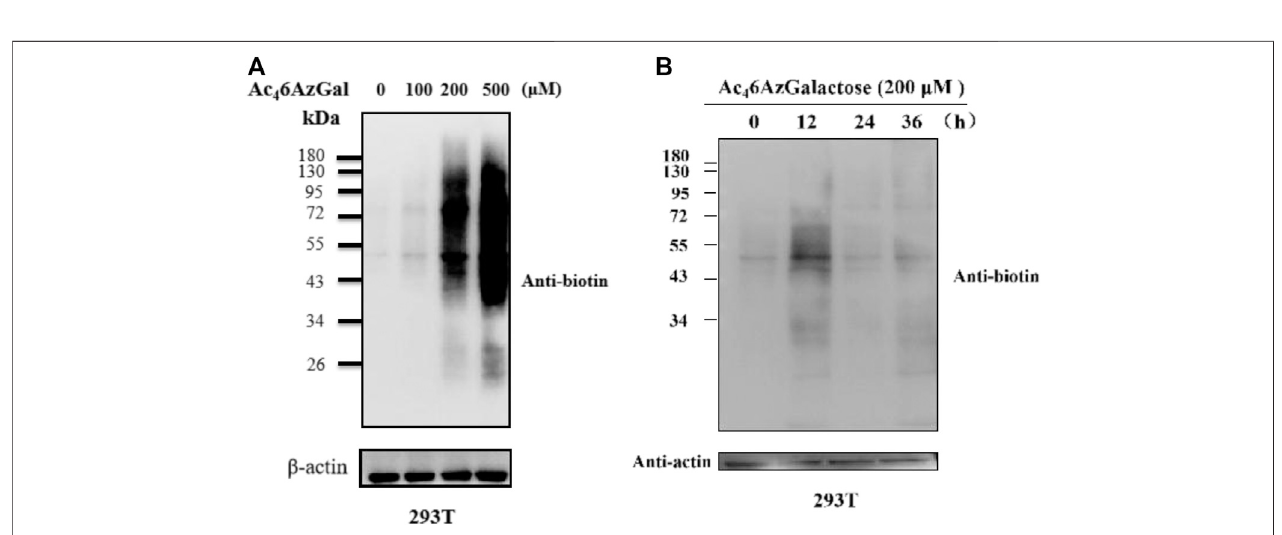
FIGURE 3 | 293T cells were treated with varying concentrations of Ac CuAAC and analysis by Western blot.